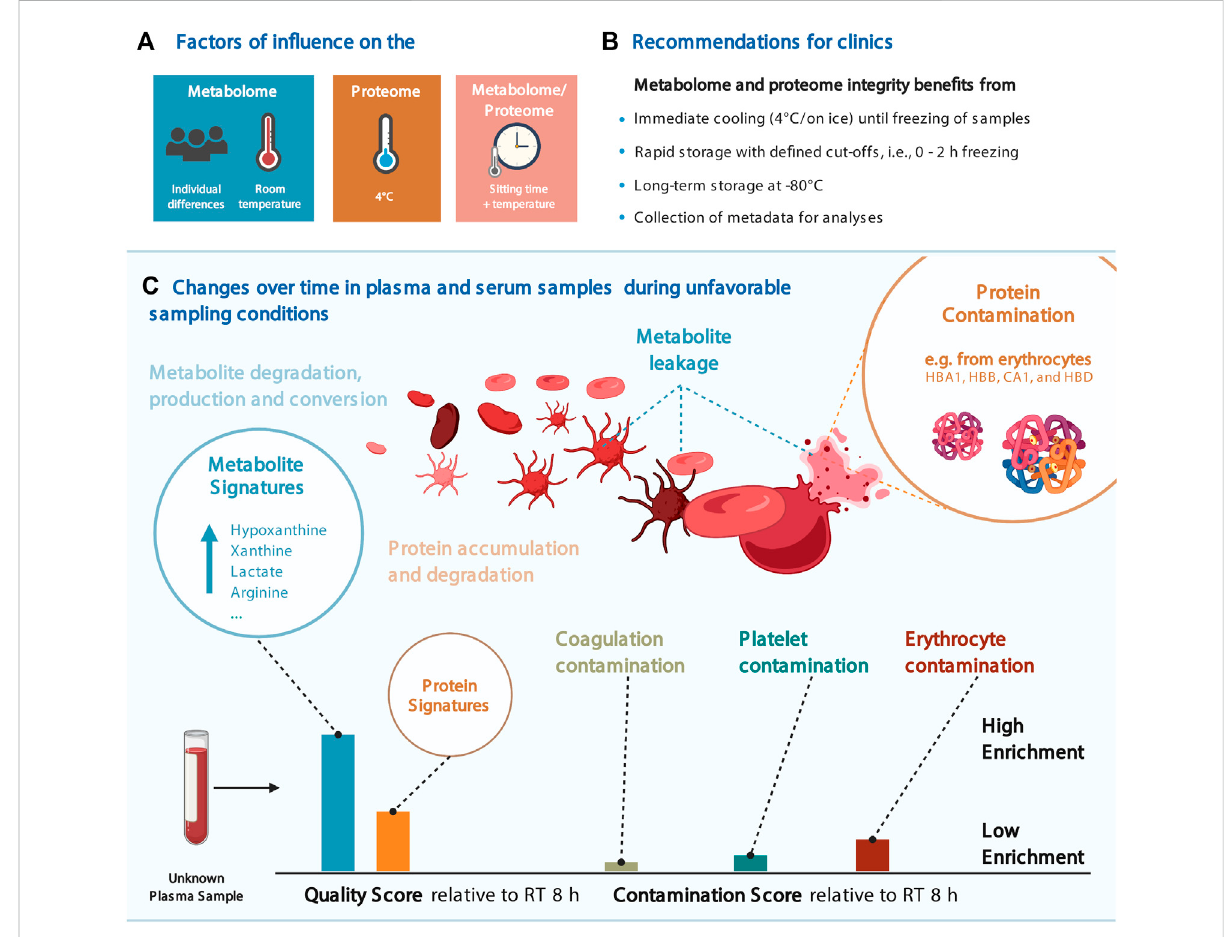
Considerations for the joint proteomic and metabolomic analysis of plasma and serum samples. (A) Most in fl uential factors on the proteome and proteome in our data. (B) Recommendations for clinical blood sampling. (C) Change over time in blood plasma and serum samples and the resulting quality and contamination scores. Several fi gures were created with